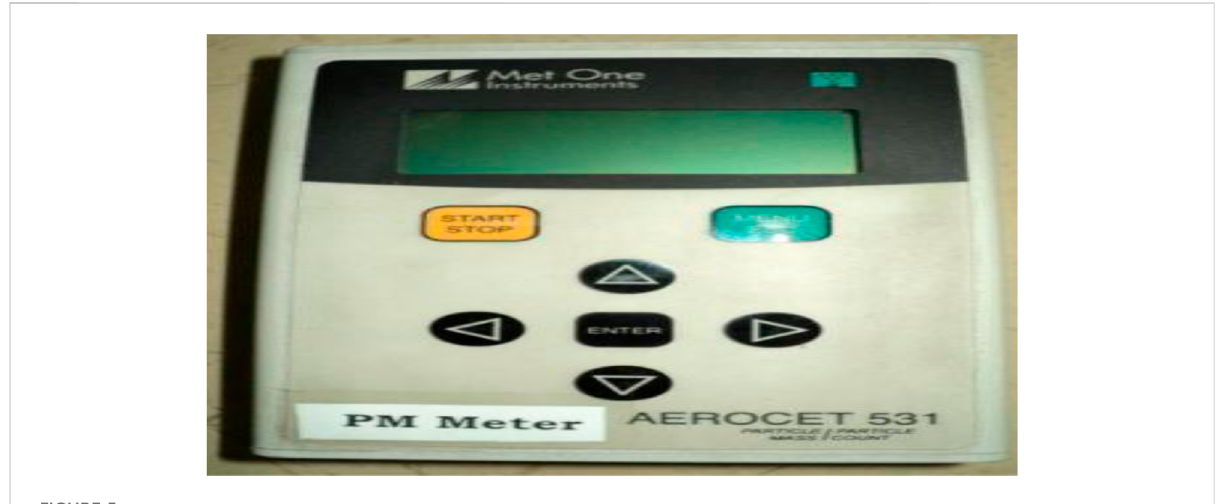
FIGURE 5 Particulate matter emission measuring